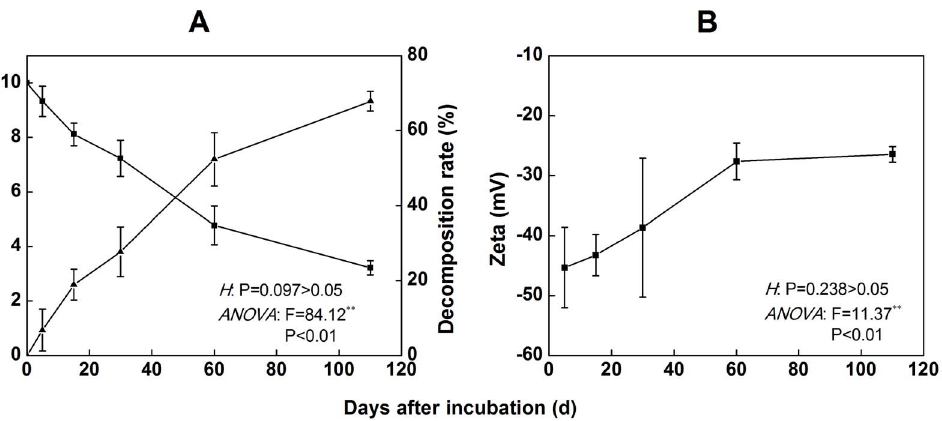
Figure 1. The characteristics of the decomposition and zeta potential of rice straw. The annotations in the panels indicate the homogeneity of variances (H) and ANOVA for the remaining dry matter and zeta potential. The H-test was performed using the Levene test. **indicates significant differences at P , 0.01. The values are the means of 3 replicates ( 6 standard deviation).